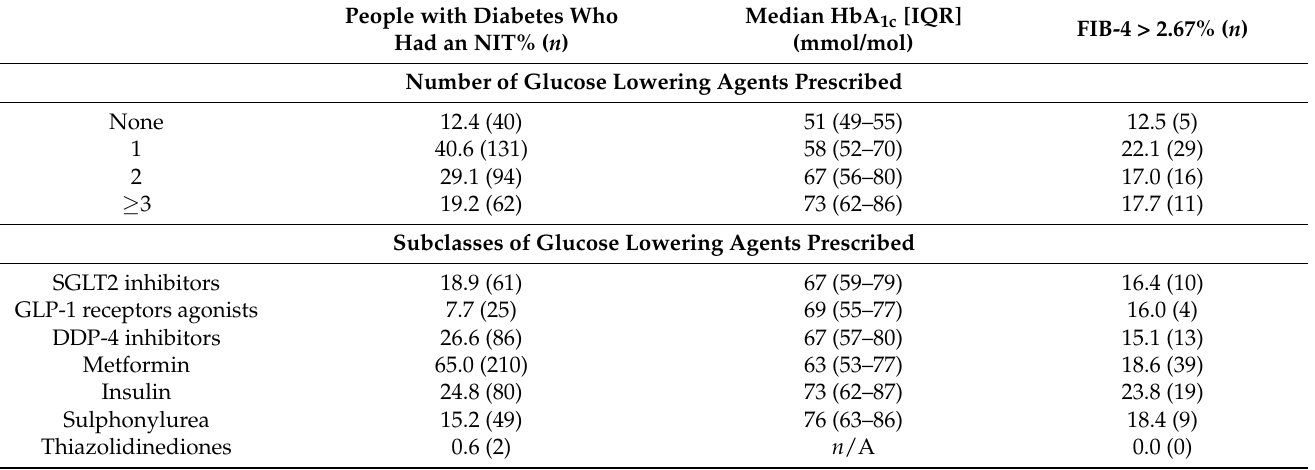
Table 3. Results of Non-Invasive Serum Fibrosis Tests for People with Diabetes according to Number and Sub-class of Glucose-Lowering Agents